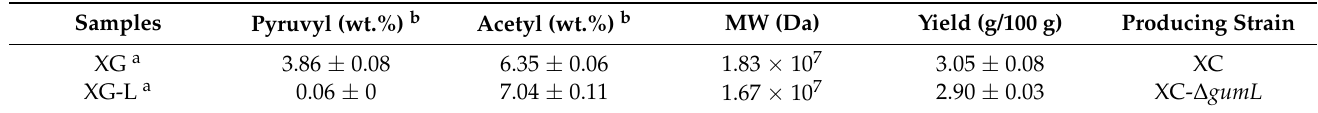
Figure 1. Main repeating units of natural xanthan gum (XG) and pyruvate-free xanthan gum (XG-L). Glc, glucose; Man, mannose; Glc A, glucuronic acid; Ac, acetyl group; Py, pyruvyl group. Table 2. Basic characteristics of natural xanthan gum and xanthan gum from genetically engineered Xanthomonas campestris strains.